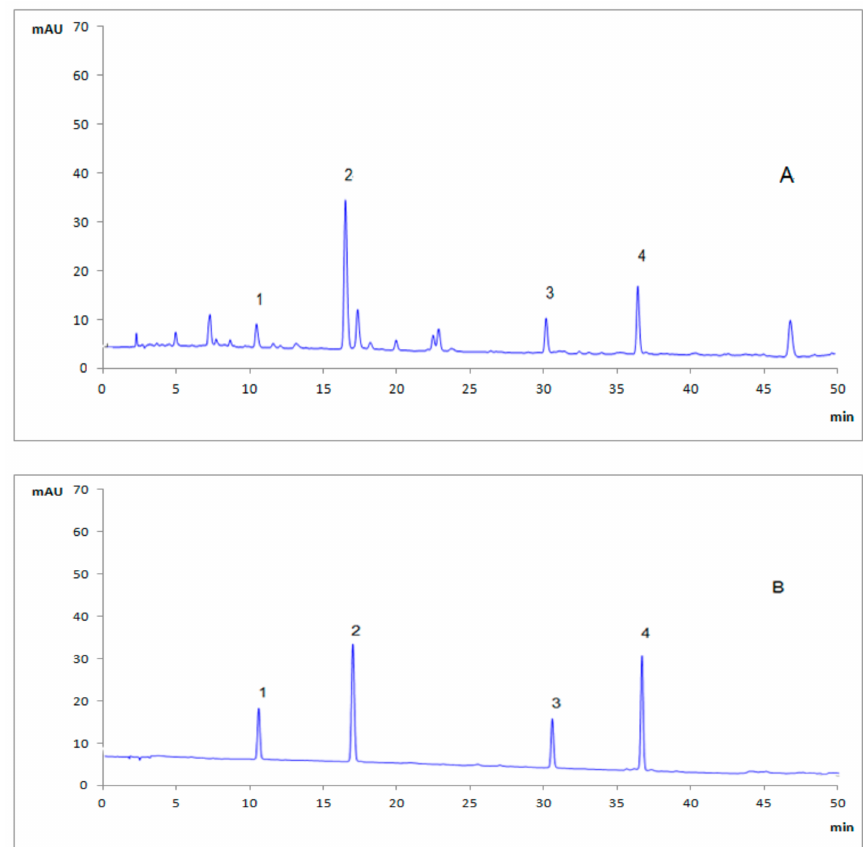
Figure 1. Typical HPLC chromatogram of sample solution of G. elata ( A ) and mixed standard solution ( B ). 1. GA, gastrodin; 2. HA, p -hydroxybenzyl alcohol; 3. PB, parishin B; 4. PA, parishin